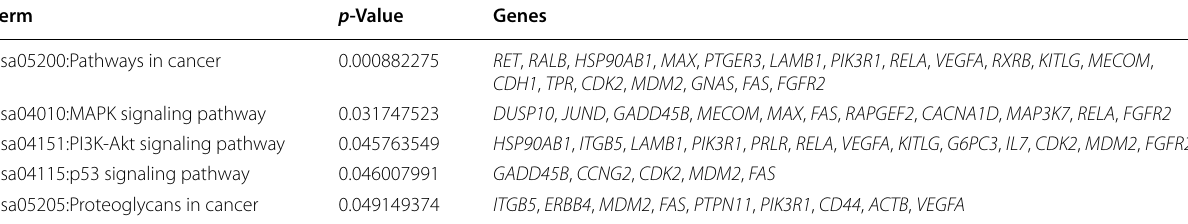
Table 2. KEGG pathway of OTGs. The signaling pathways in the table are usually involved in cancer Term p -Value Genes hsa05200:Pathways in cancer 0.000882275 hsa04010:MAPK signaling